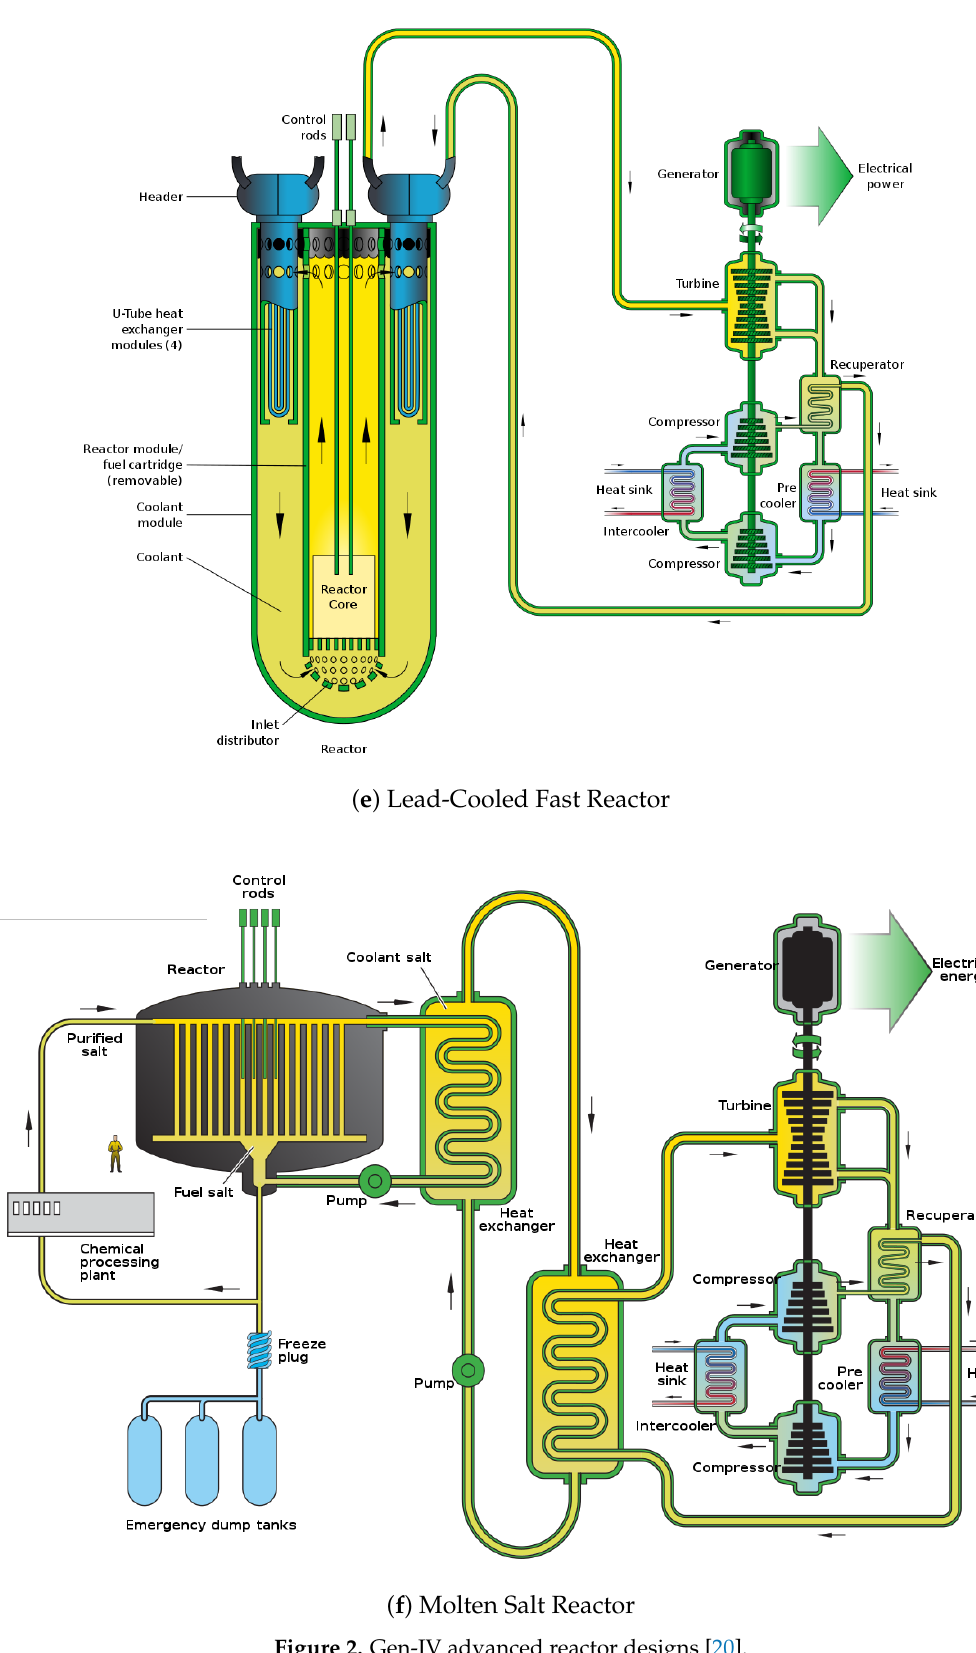
Figure 2. Gen-IV advanced reactor designs